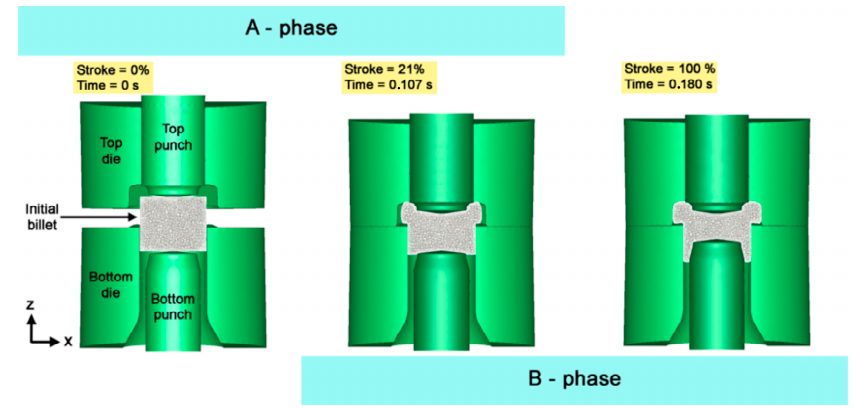
Figure 1. Set-up of the single-stage forging test.